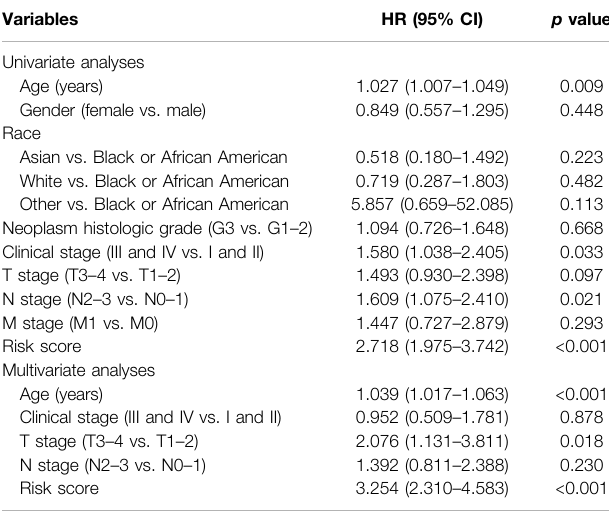
TABLE 2 | Univariate and multivariate analyses of risk factors with and OS in the training cohort. Variables